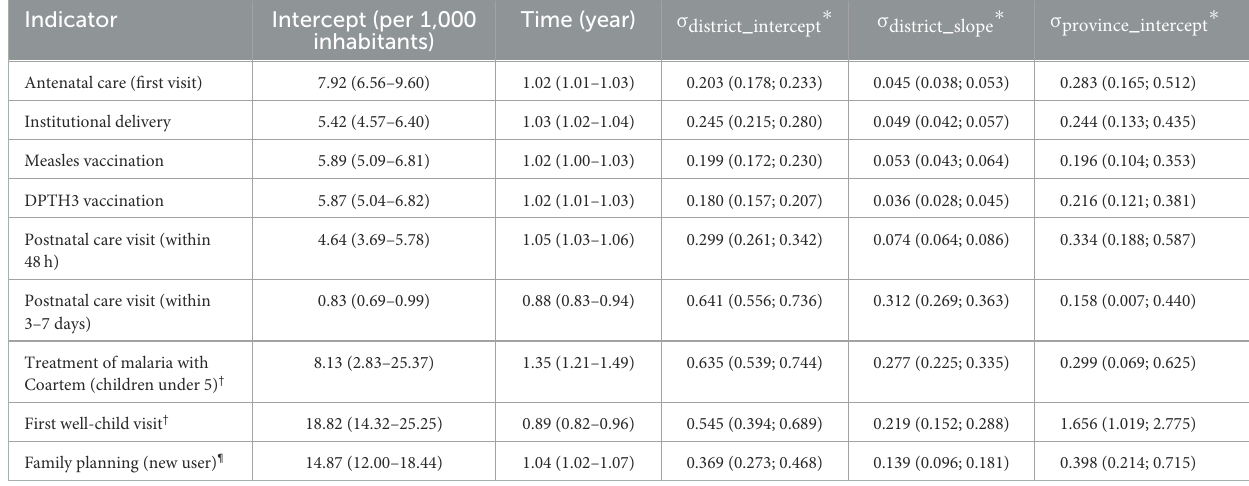
TABLE 3 Mixed-effect negative binomial regression coefficients for selected indicators, January 2017 to December 2019.